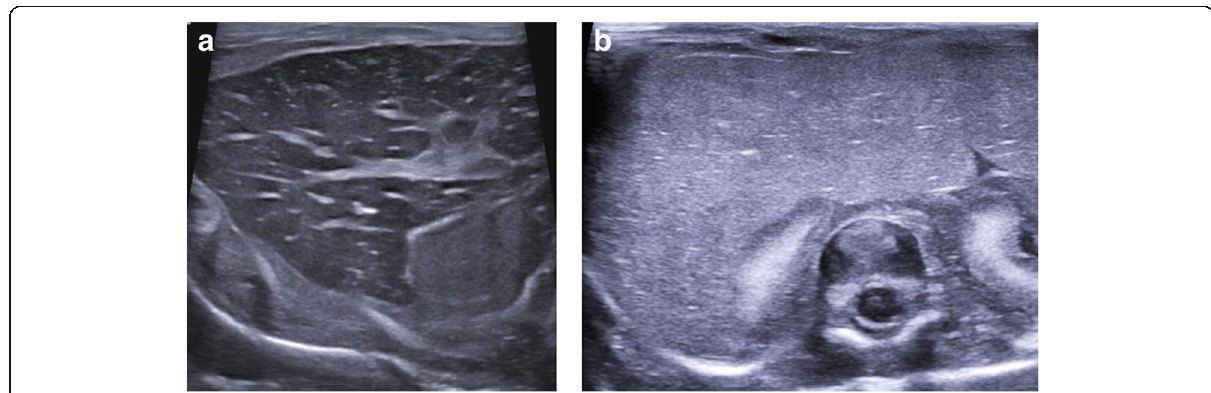
Fig. 14 Transverse postmortem ultrasound images of a normal liver in two different foetuses, both acquired 12days after death. The liver in image ( a ) demonstrates marked periportal echogenicity and was obtained in a 32-week gestational-aged stillborn foetus. In image ( b ), there are fewer periportal echoes in this 21-week gestational-aged foetus following termination of pregnancy for oligohydramnios. The causes for these differences is unknown and could relate to different phases of decomposition or gestational age, as both livers were histologically normal at